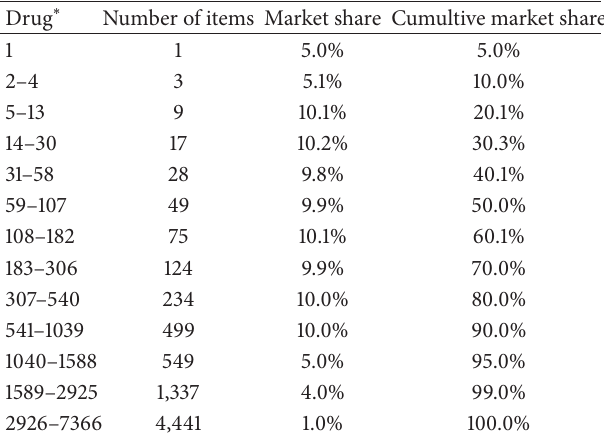
Table2:MarketshareofcostsbydrugitemwithinTaiwan’sNational Health Insurance in 2007.